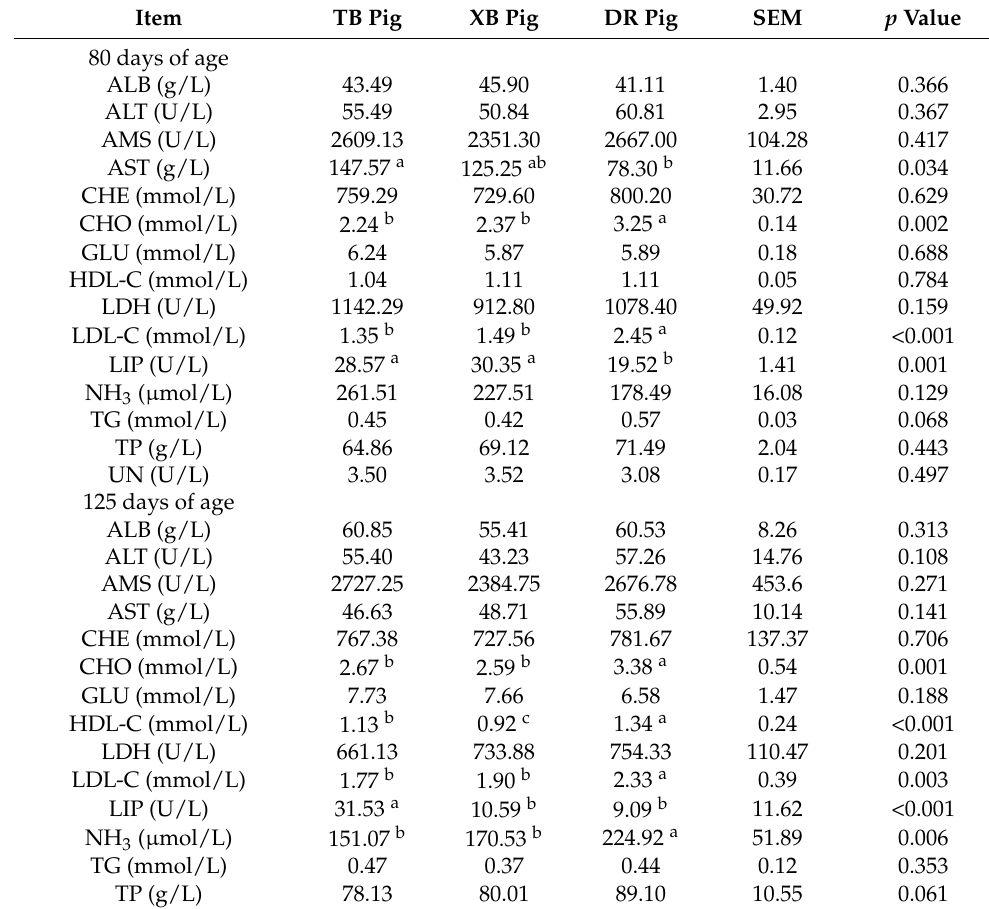
Data are presented as means, SEM, and p values ( n = 10). Values in the same row without a common superscript letter are different ( p < 0.05). TB pig, Taoyuan black pig; XB pig, Xiangcun black pig; DR pig, Duroc pig; ADG, average daily gain; ADFI, average daily feed intake; FCR, feed/gain ratio. Table 4. Plasma biochemical parameters of three pig breeds at different ages.